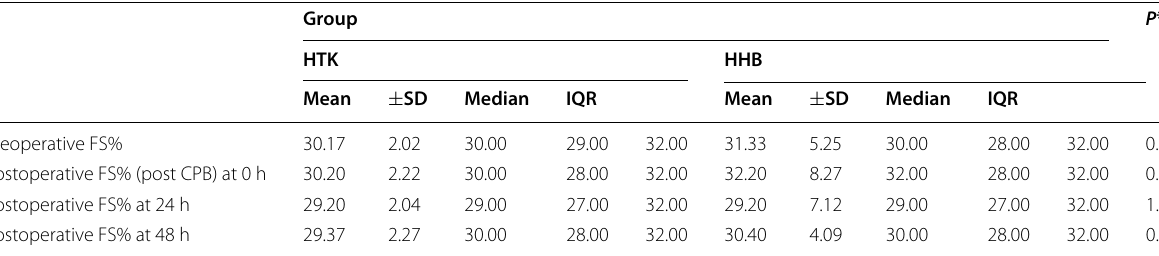
Table 5 Fractional shortening in both groups